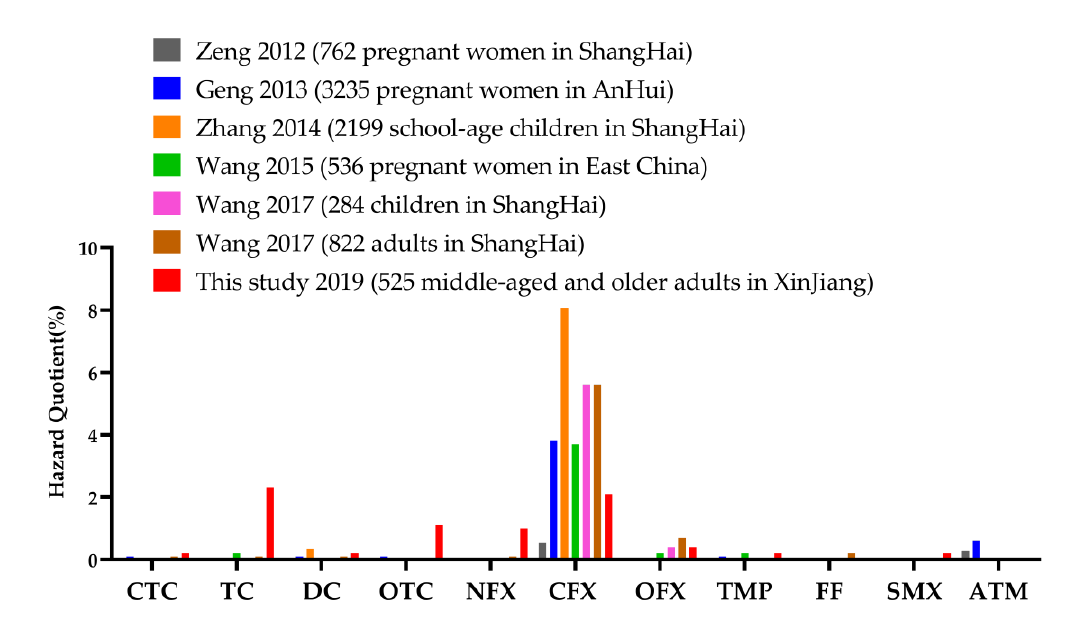
Figure 1. Comparison of hazard quotients of 11 antibiotics in urine between this study and six previous studies conducted by Zeng et al. [28], Geng et al. [29], Zhang et al. [30], Wang et al. [20], Wang et al. [31] and Wang et al. [6]. (CTC: Chlortetracycline; TC: Tetracycline; DC: Doxycycline; OTC: Oxytetracycline; NFX: Norfloxacin; CFX: Ciprofloxacin; OFX: Ofloxacin; TMP: Trimethoprim; FF: Florfenicol; SMX: Sulfamethoxazole: ATM: Azithromycin).